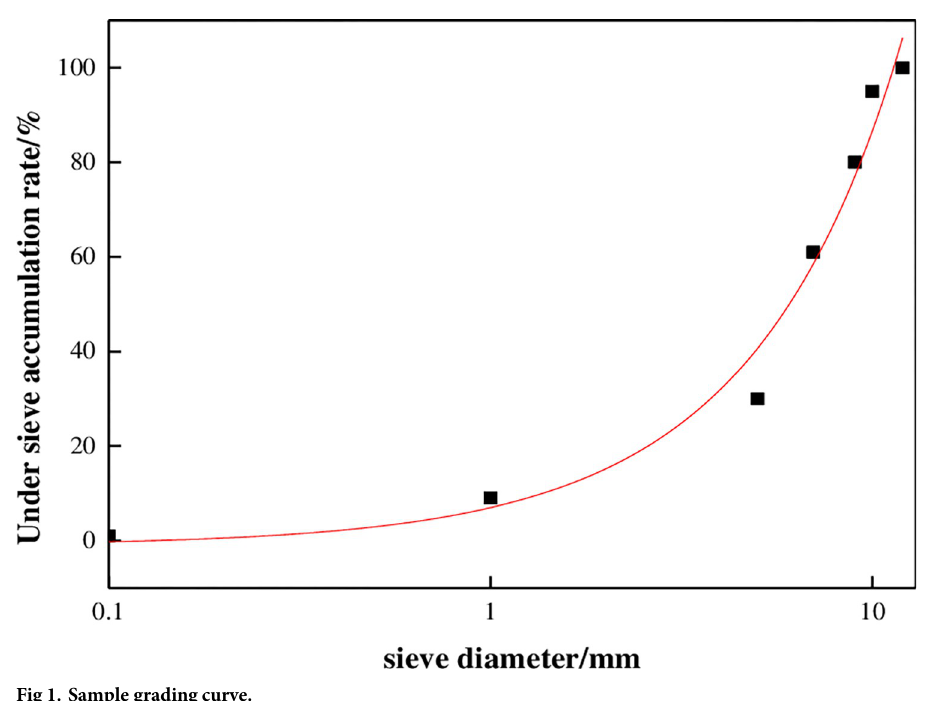
Fig 1. Sample grading